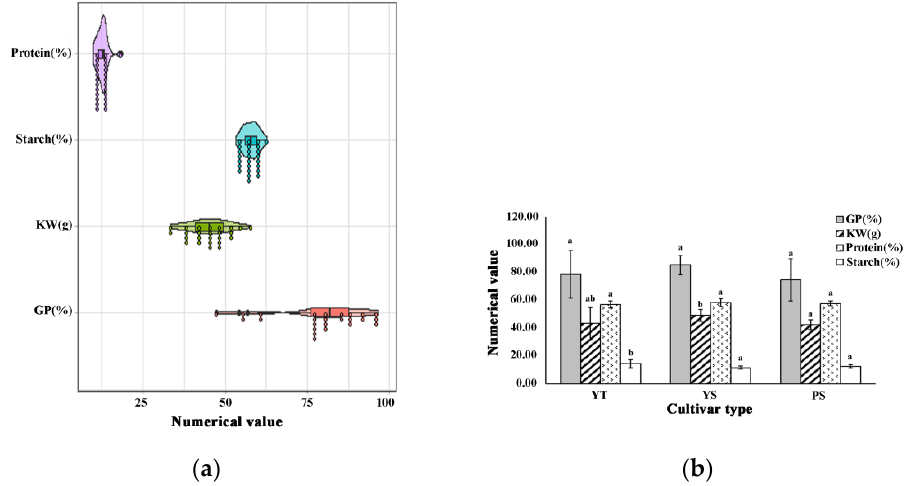
Figure 1. The cultivar variation in germination percentage, kernel weight, starch, and protein. ( a ) Cultivar variation in germination percentage, kernel weight, starch, and protein; ( b ) the difference of germination percentage, kernel weight, starch, and protein among different cultivar types. YT, two-rowed yellow highland barley; YS, six-rowed yellow highland barley; PS, six-rowed purple highland barley. GP, germination percentage; KW, kernel weight; Different letters denote significant difference among different highland barley cultivar types at the level p < 0.05.